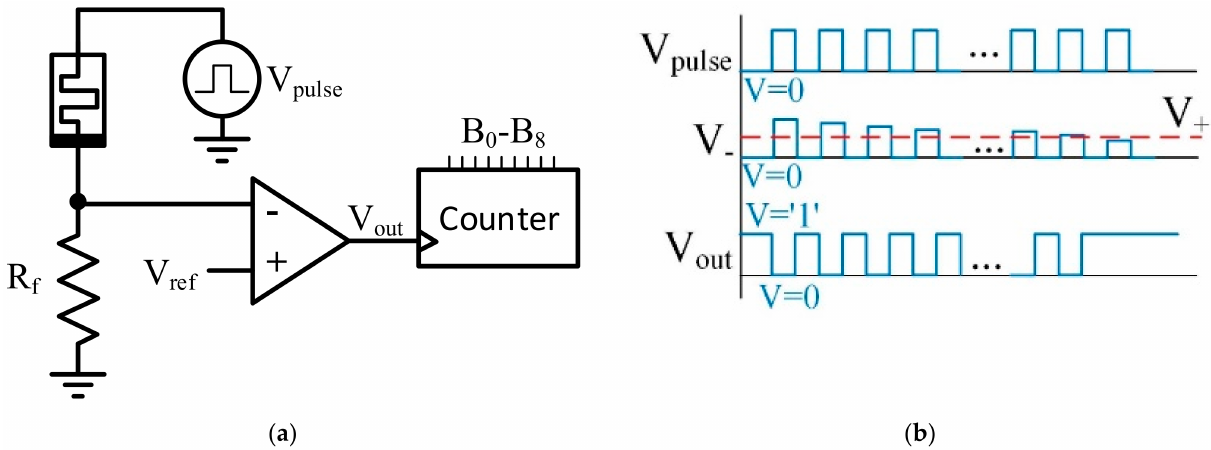
Figure 7. ( a ) Schematic of the proposed TRNG (resistive divider, V ref , comparator, and a counter). ( b ) Diagram of the voltage pulse operation.